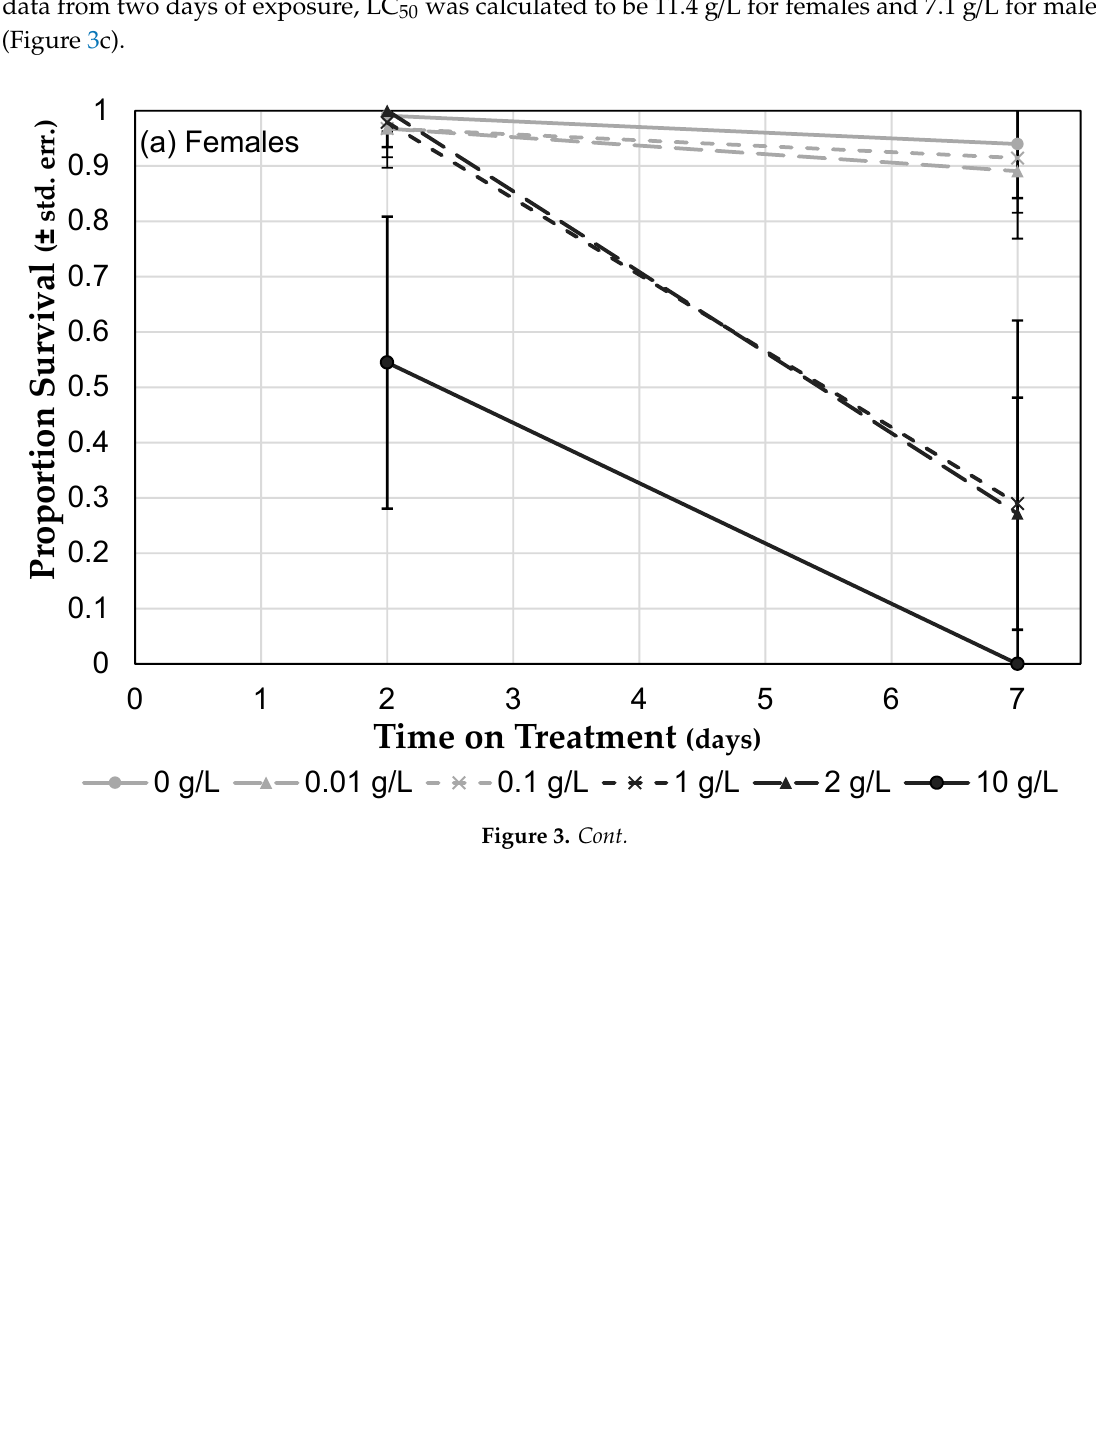
12 of 29 Table 1. Glyphosate analysis for three types of corn.